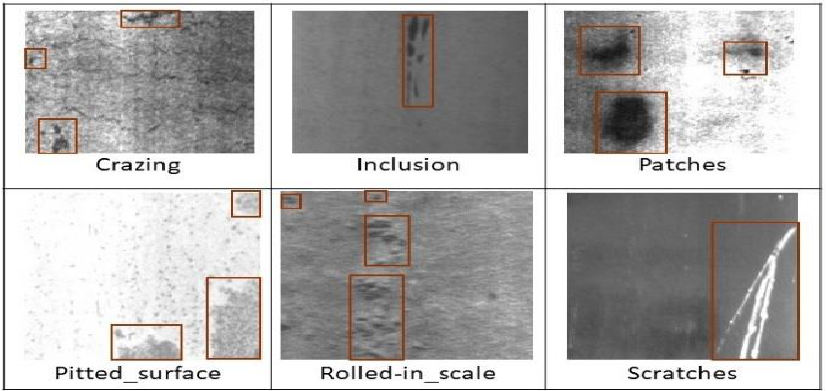
Figure 1. Six types of surface steel strips defect.